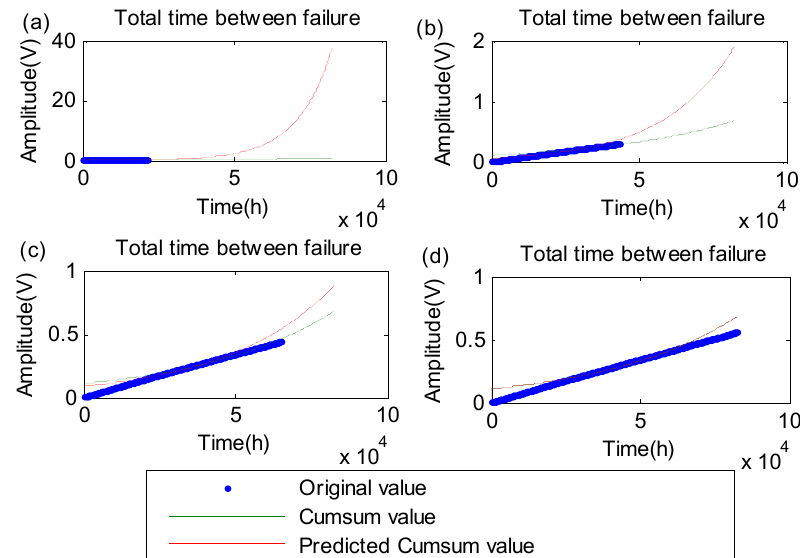
Figure 9. The RUL prognostic results with the energy of the accumulative signal utilizing grey theory: ( a ) prognostics result based on 25% of the accumulative data; ( b ) prognostics result based on 50% of the accumulative data; ( c ) prognostics result based on 75% of the accumulative data; ( d ) prognostics result based on 100% of the accumulative data. For the kurtosis feature, the RUL prognostics results are shown in Figure 10 and Table 3. The accuracies of RUL prognostics are 0.4280, 0.6924, 0.8762, and 0.9909 based on 25%, 50%, 75%, and